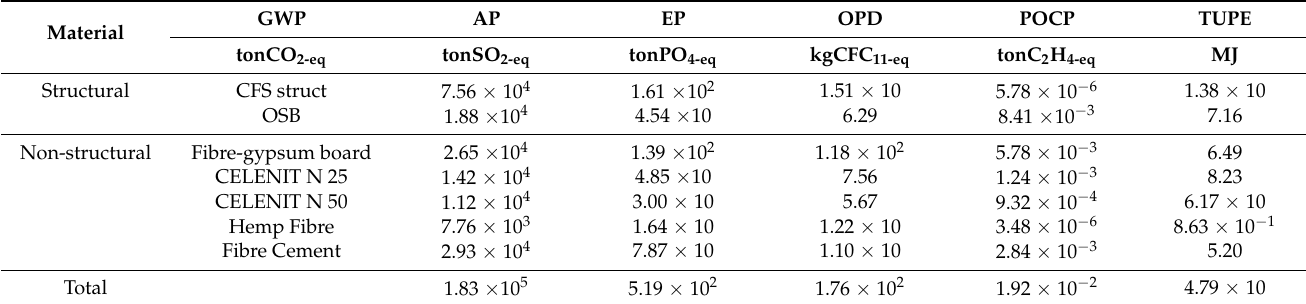
Figure 12. LCIA results: non-load-bearing walls. Table 13. Results of Life Cycle impact assessment: non-load-bearing walls. Material